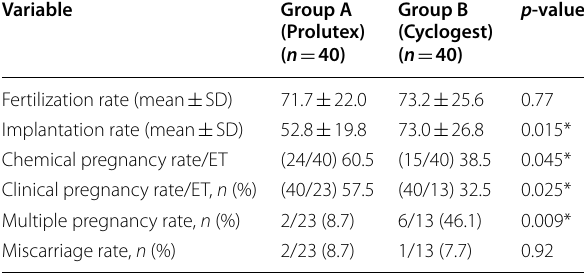
Table 3 Comparison of the IVF/ICSI cycle outcomes between two